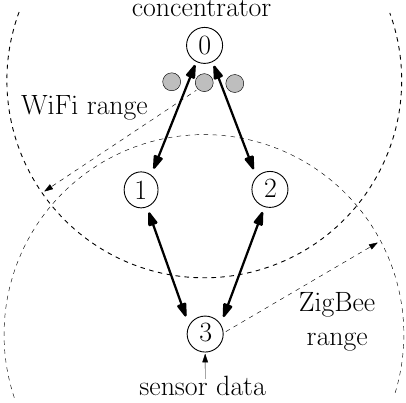
Figure 5. Topology where ZigBee devices share same spectrum as WiFi